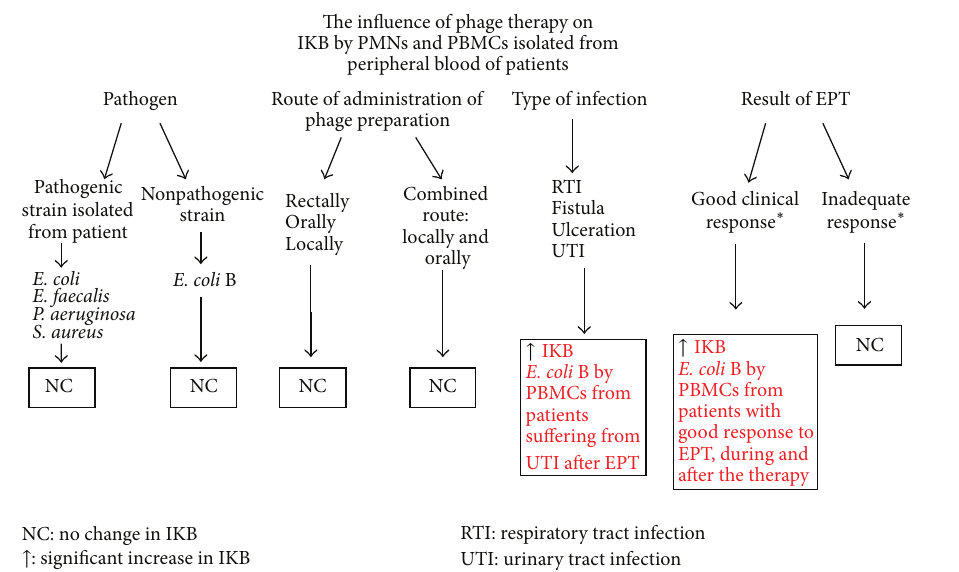
isolated from patients’ blood to kill bacteria intracellularly is presented in Figure